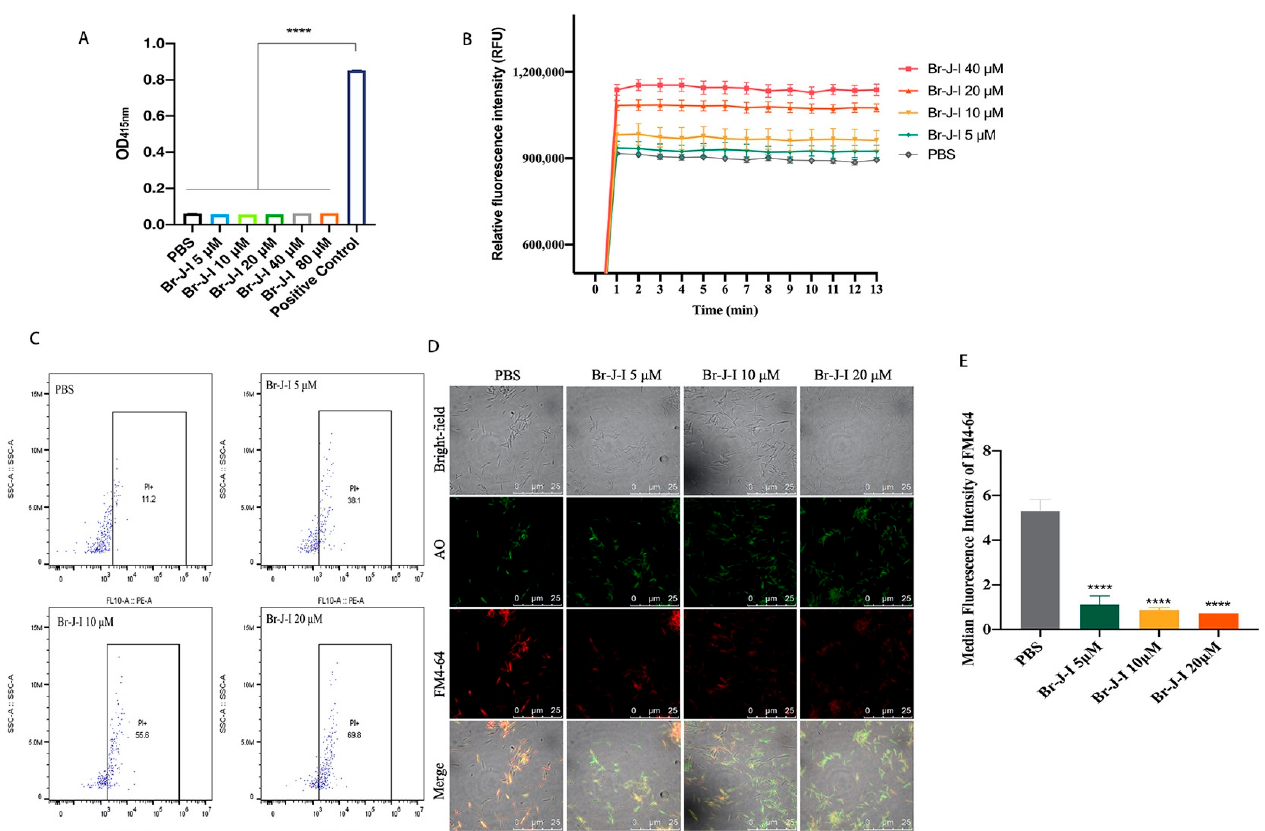
Figure 2. The mechanism of antibacterial activity of Br-J-I. ( A ) The effect of Br-J-I on the levels of intracellular hydrogen peroxide within Fn. ( B ) Dose dependent outer membrane permeabilization of Fn by Br-J-I . Time course of fluorescence of NPN bound to inner phospholipid membrane of Fn induced by different concentrations of Br-J-I. ( C ) Flow cytometry analysis of PI uptake of Fn induced by different concentrations of Br-J-I. ( D ) Confocal microscopic image of Fn co-stained with AO and FM4-64 with different concentrations of Br-J-I, scale bar: 25 μ m . PBS was used as a negative control. ( E ) Quantitation of FM4-64 fluorescence intensity in C. PBS was used as a negative control. Each experiment was replicated at least three times independently. All values are represented as mean ± SEM. **** p < 0.0001, vs. Fn group.